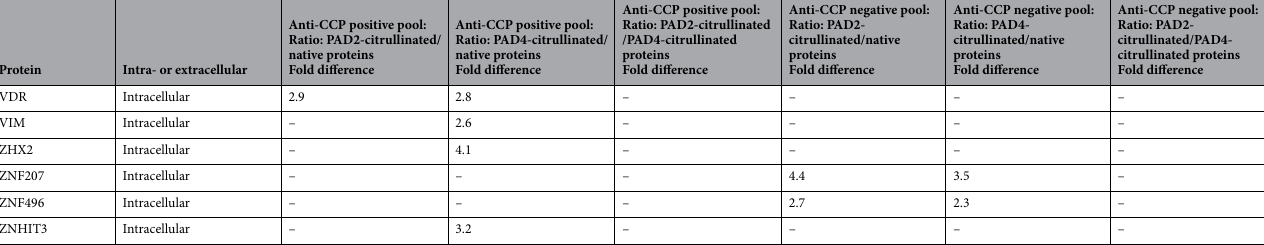
Table 1. Autoantigens targeted differentially by ACPAs after different citrullination procedures. Requirements for inclusion in the table were z score > 2, CV < 15, CI-P < 0.05, fold difference > 2, and a BH corrected P value < 0.05. ACAT2 acetyl-CoA acetyltransferase, AFF4 AF4/FMR2 family member 4, APPL1 DCC-interacting protein 13-alpha, BAG3 BAG family molecular chaperone regulator 3, C1orf174 UPF0688 protein C1orf174, C21orf2 protein C21orf2, C21orf33 ES1 protein homolog, CAMK2B calcium/calmodulin-dependent protein kinase type II subunit beta, CAMK2G calcium/calmodulin-dependent protein kinase type II subunit